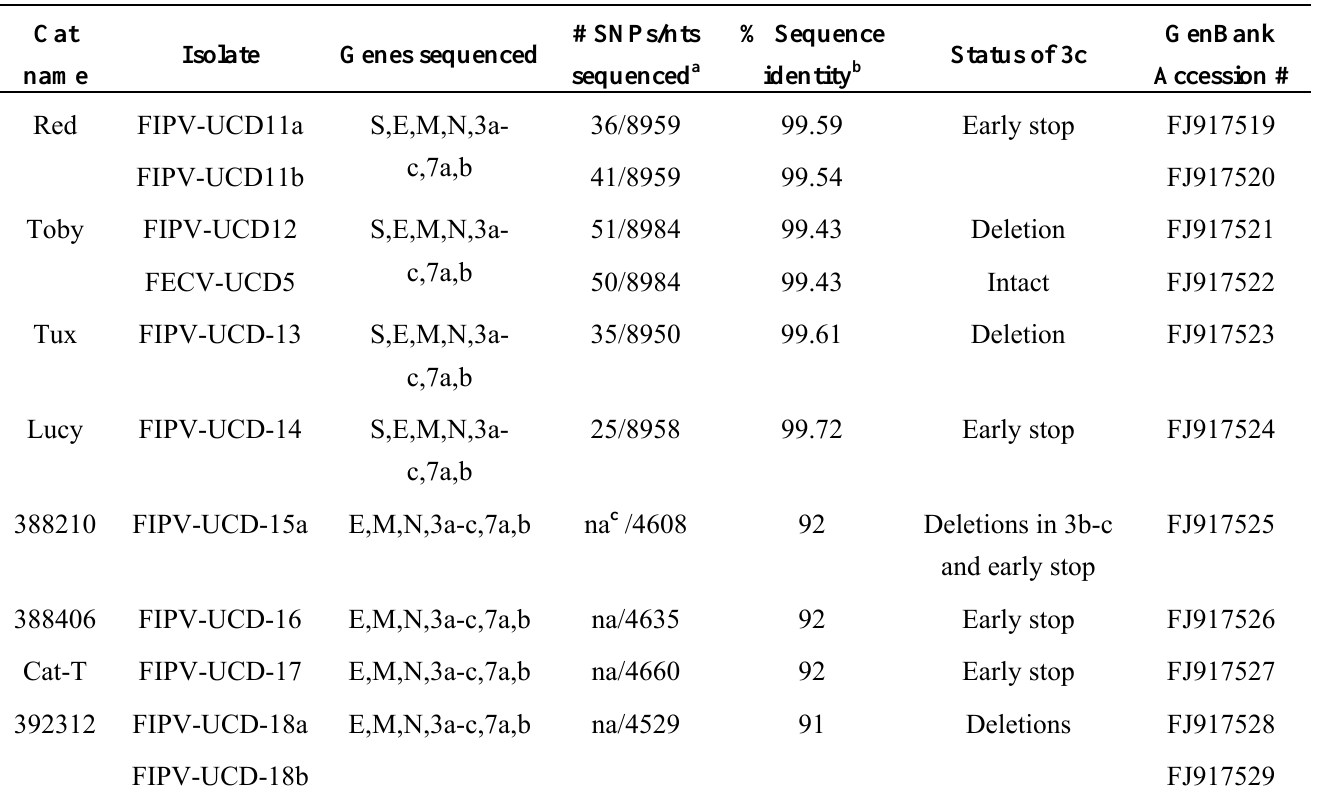
Table 1. Name and biotype designation of coronavirus isolates (including variants) from diseased tissues of eight cats dying of FIP. The genes that were sequenced, their mutability, degree of relatedness, and the nature of the functional mutation in the 3c gene are given for each